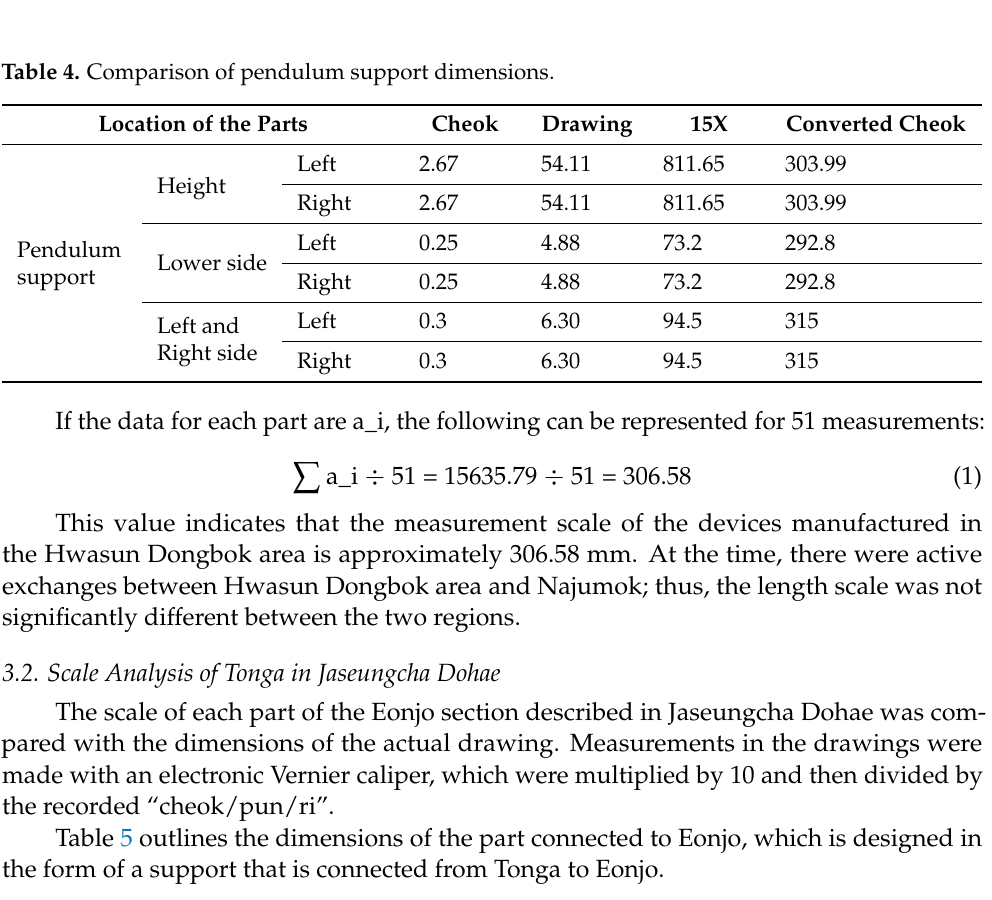
Table 5. Comparison of Eonjo support dimensions.